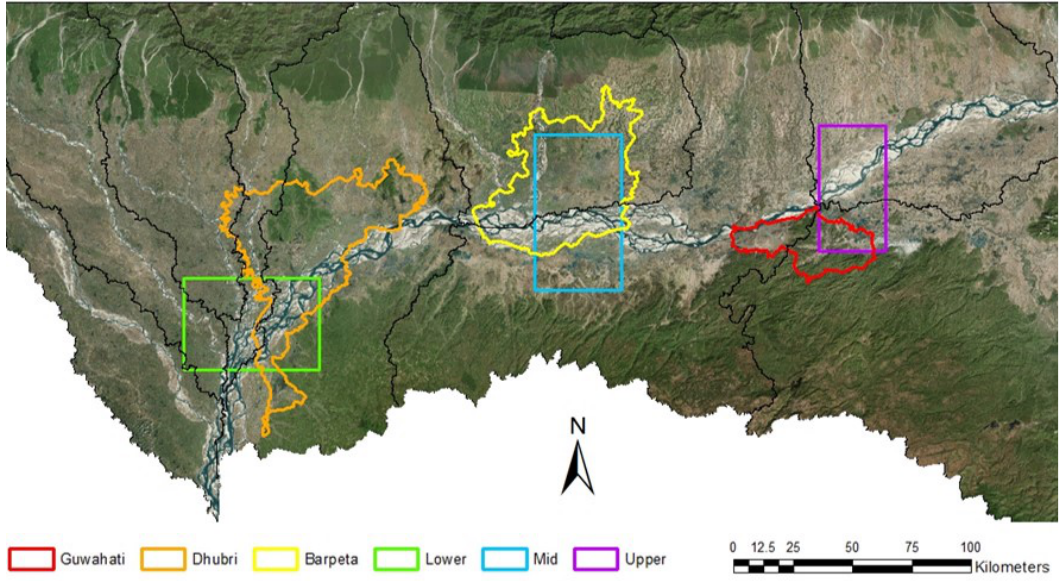
Figure 9. Considered areas for the evaluation of the hydraulic model